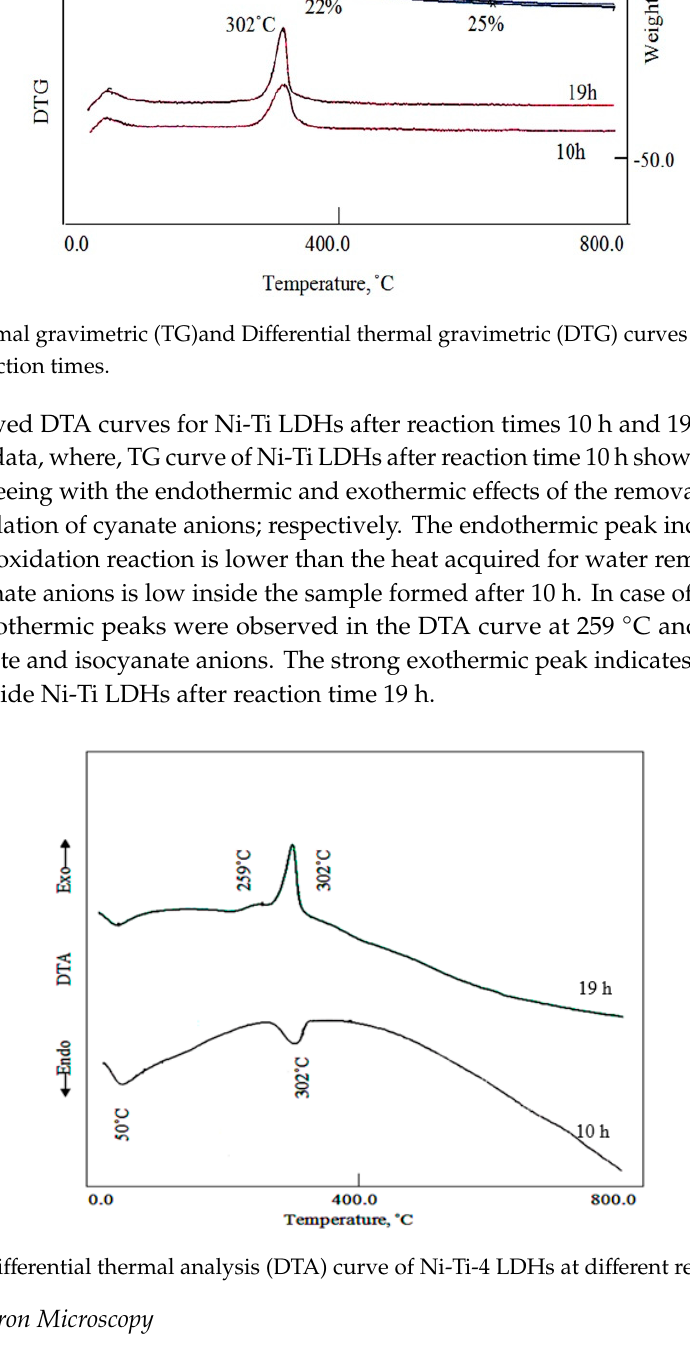
Figure 6. Di ff erential thermal analysis (DTA) curve of Ni-Ti-4 LDHs at di ff erent reaction Figure 6. Differential thermal analysis (DTA) curve of Ni-Ti-4 LDHs at different reaction times.